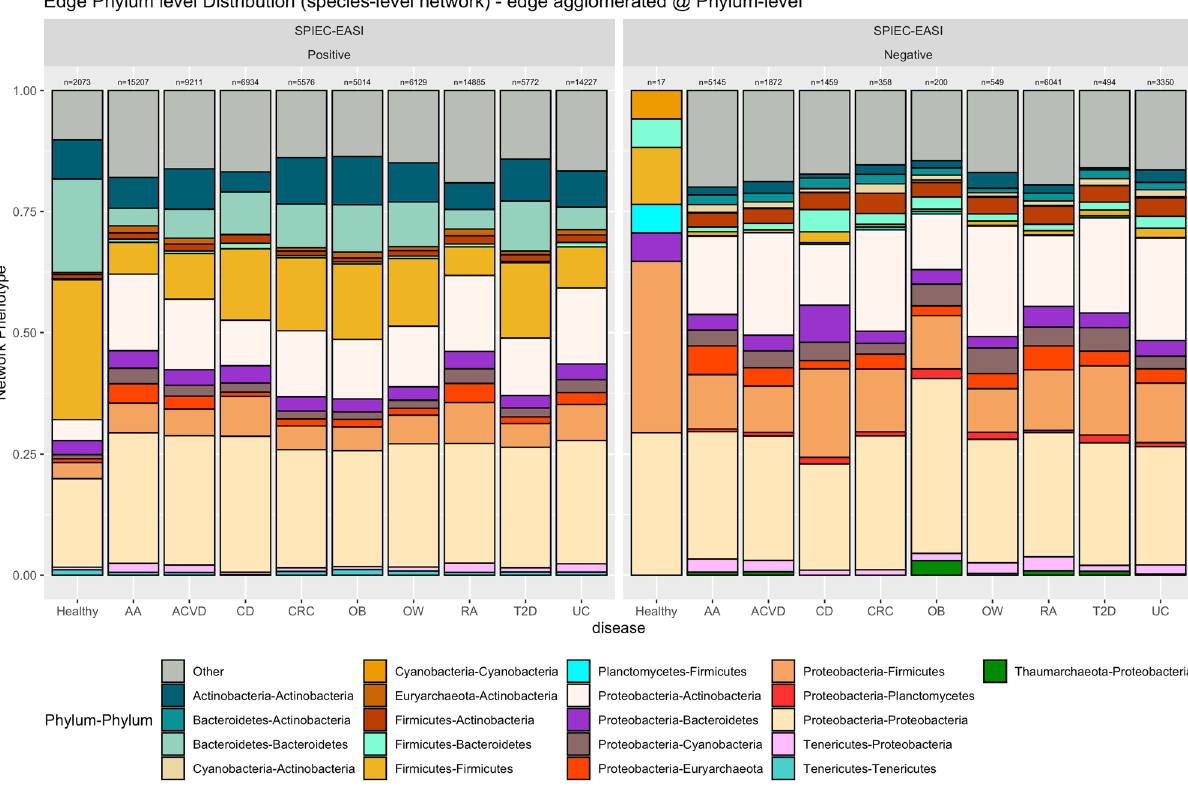
Figure 6. Taxonomic distribution (at the Phylum level) of the species involved in microbiome association networks by phenotype. (left) Positive edge distribution stacked barplots, (right) Negative edge distribution stacked barplots.